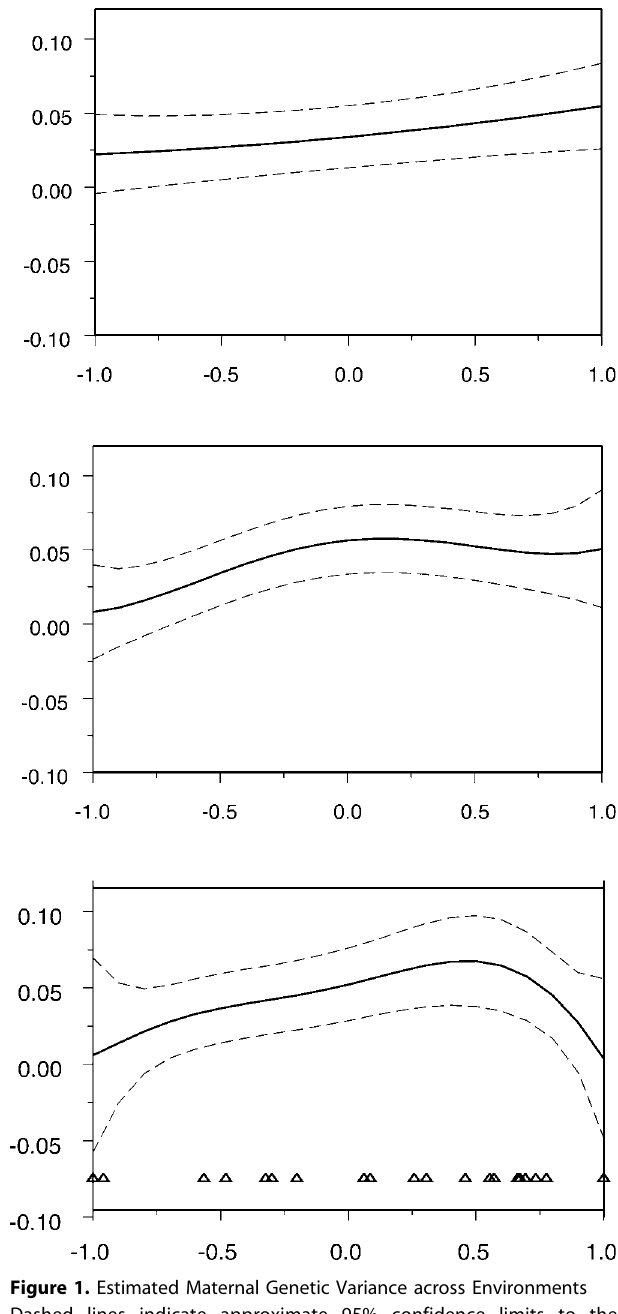
Figure 1. Estimated Maternal Genetic Variance across Environments Dashed lines indicate approximate 95% confidence limits to the estimated maternal genetic variance ( V M ), while triangles on the lower panel indicate the actual distribution of environmental quality (E) across years. All three models suggest a general increase in V M as environmental quality increases. DOI: 10.1371/journal.pbio.0040216.g001